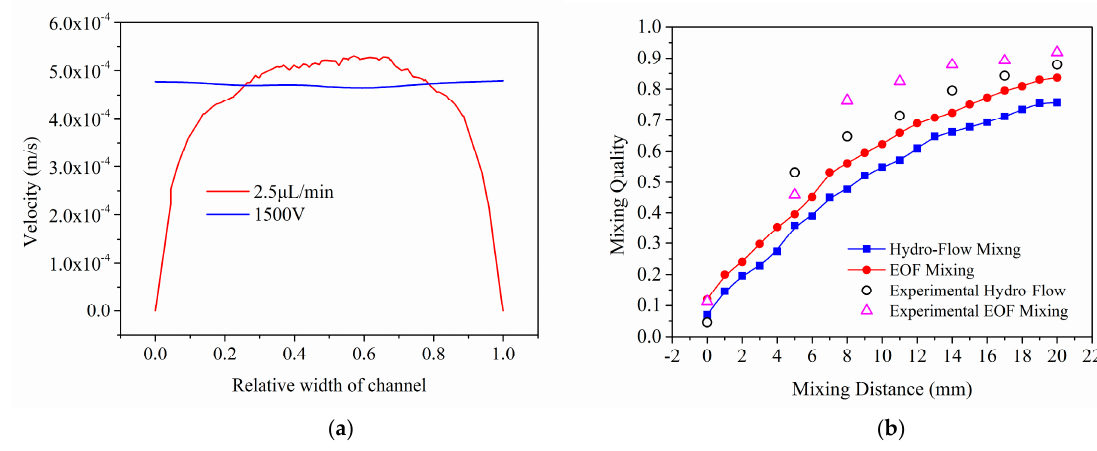
Figure 8. ( a ) Comparison of flow field distribution under two driven modes, the flow rate at outlet equals in both modes; ( b ) Comparison of mixing quality under both driven modes, and comparison simulation results and experimental results.